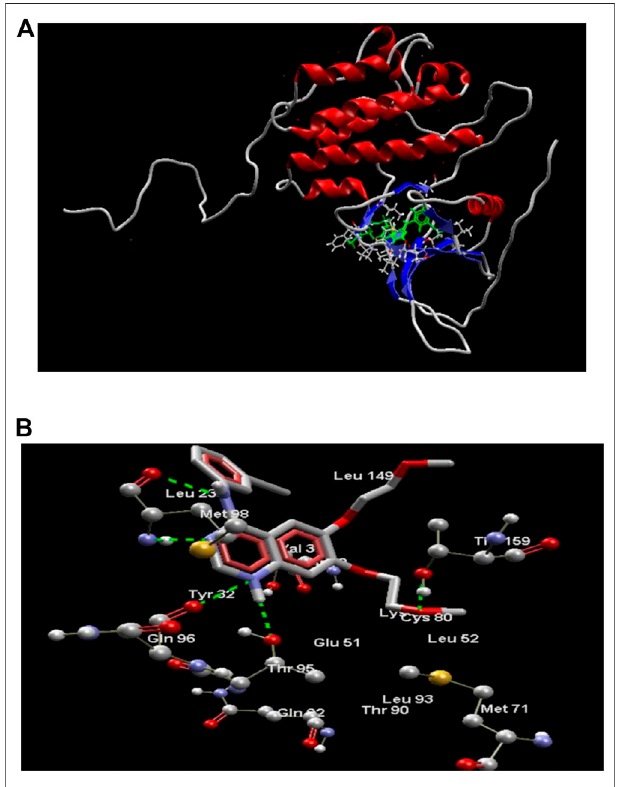
FIGURE2|(A) Structure ofEGFRK domain complexedwith4-AQ (PDB ID: 1m17). (B) 4-AQ docked in its best conformation (pose) into the active site of EGFRK.